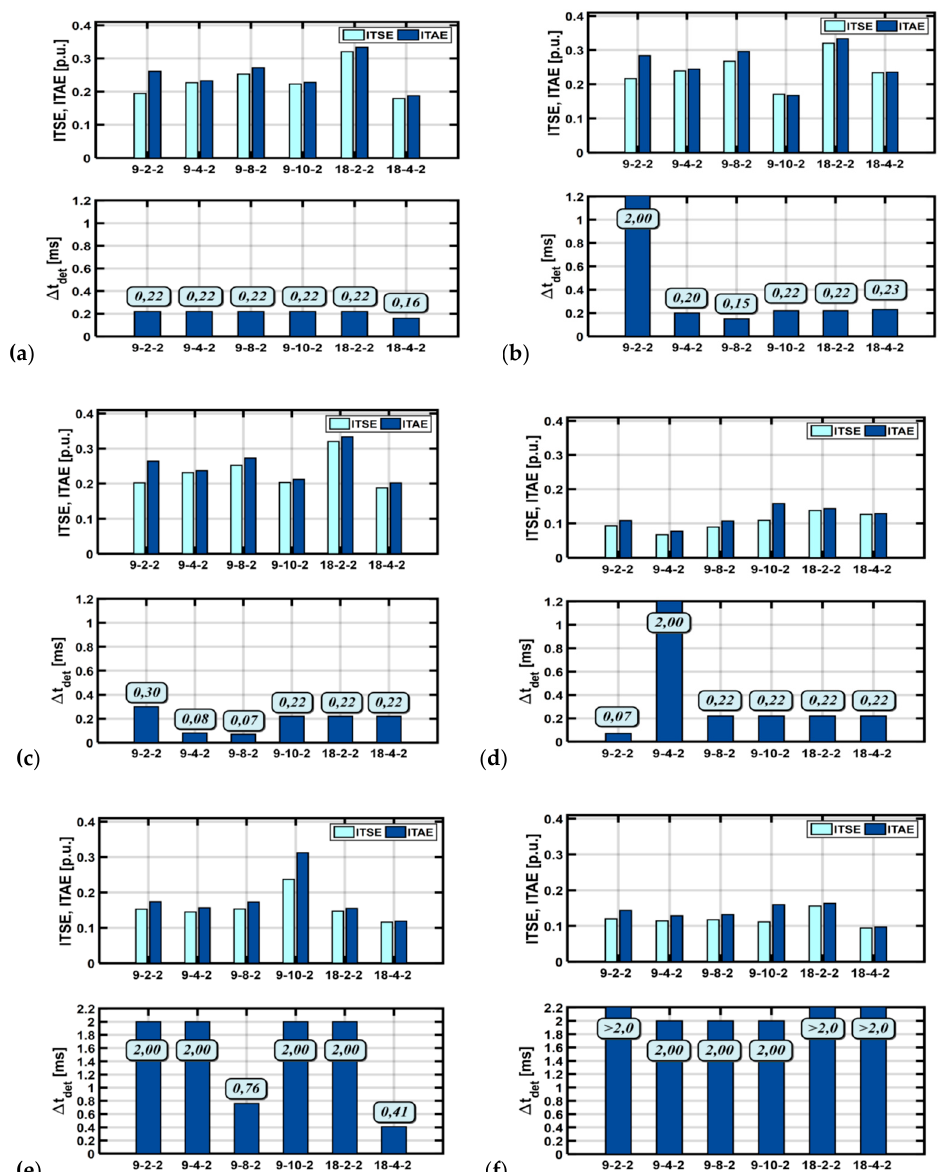
Figure 11. Bar charts with the values of ITSE and ITAE integral quality indicators and fault detection times for different NN learning cycles: ( a , d ) operation of the drive with a rated speed value, ( b , e ) rated speed and load torque values, ( c , f ) low speed value failure detection of the current transducer phase A ( a , b , c ) and phase B ( d , e , f ), simulation results.